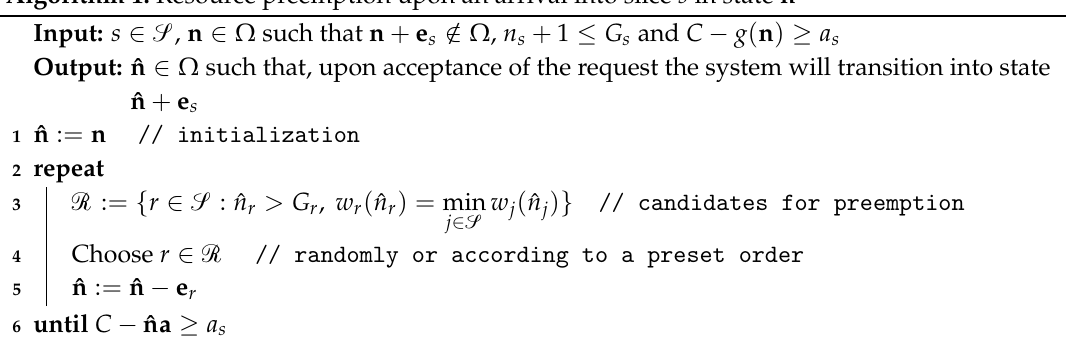
Algorithm 1: Resource preemption upon an arrival into slice s in state